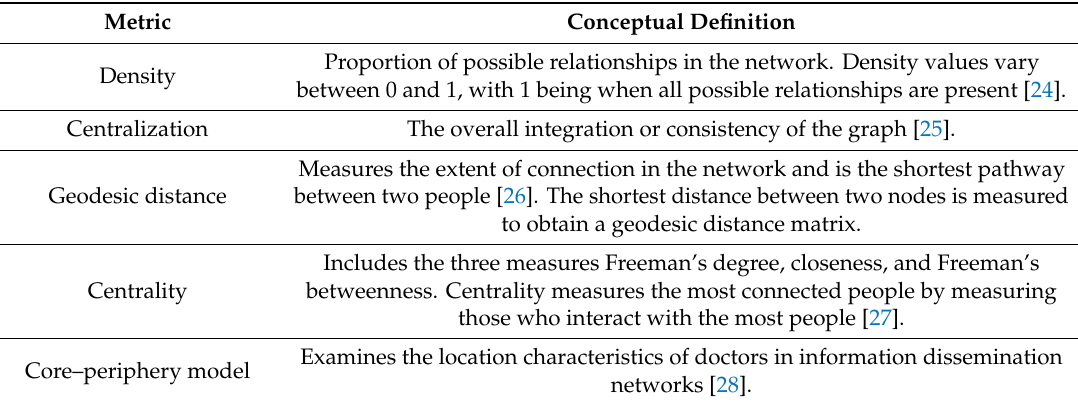
Table 2. Metrics and conceptual definitions of the social network